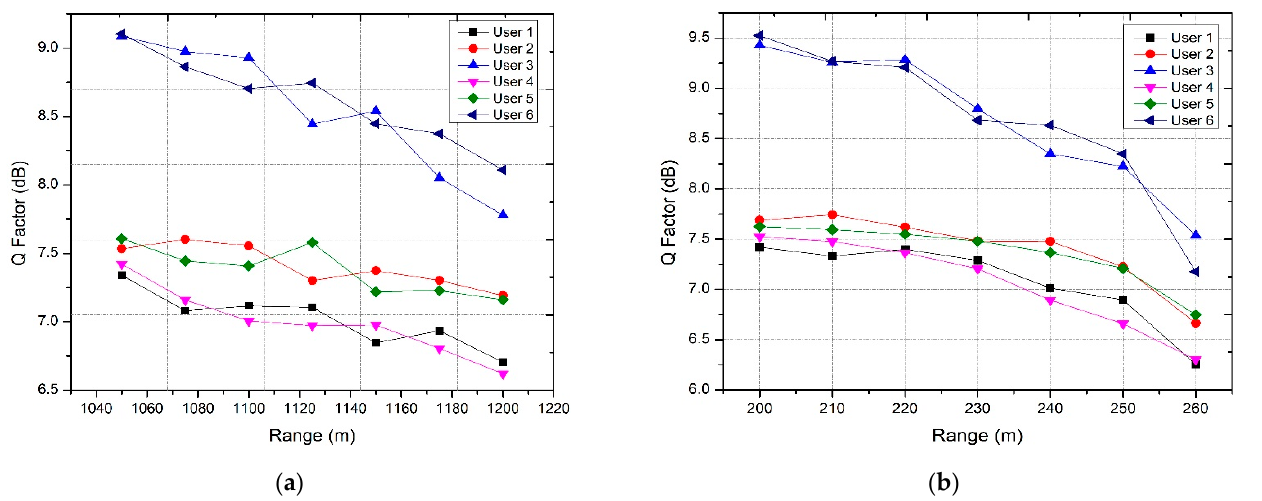
Figure 9. Q-factor for PDM-SAC-OCDMA-enabled FSO transmission versus range under ( a ) WSF and ( b ) DSF.